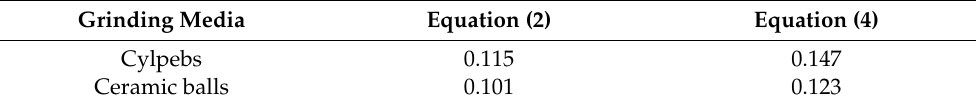
Figure 4. The first-order plots for cylpebs and ceramic balls at the same charge volume. Table 9. A comparison of the specific breakage rates between Equations (2) and (4).